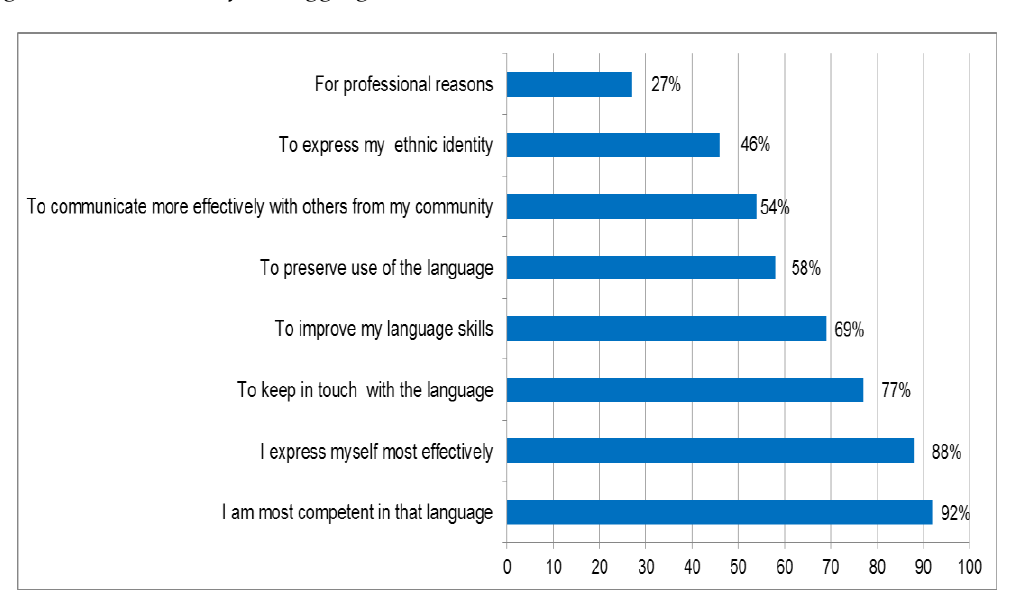
Figure 6: Motivations for Blogging in